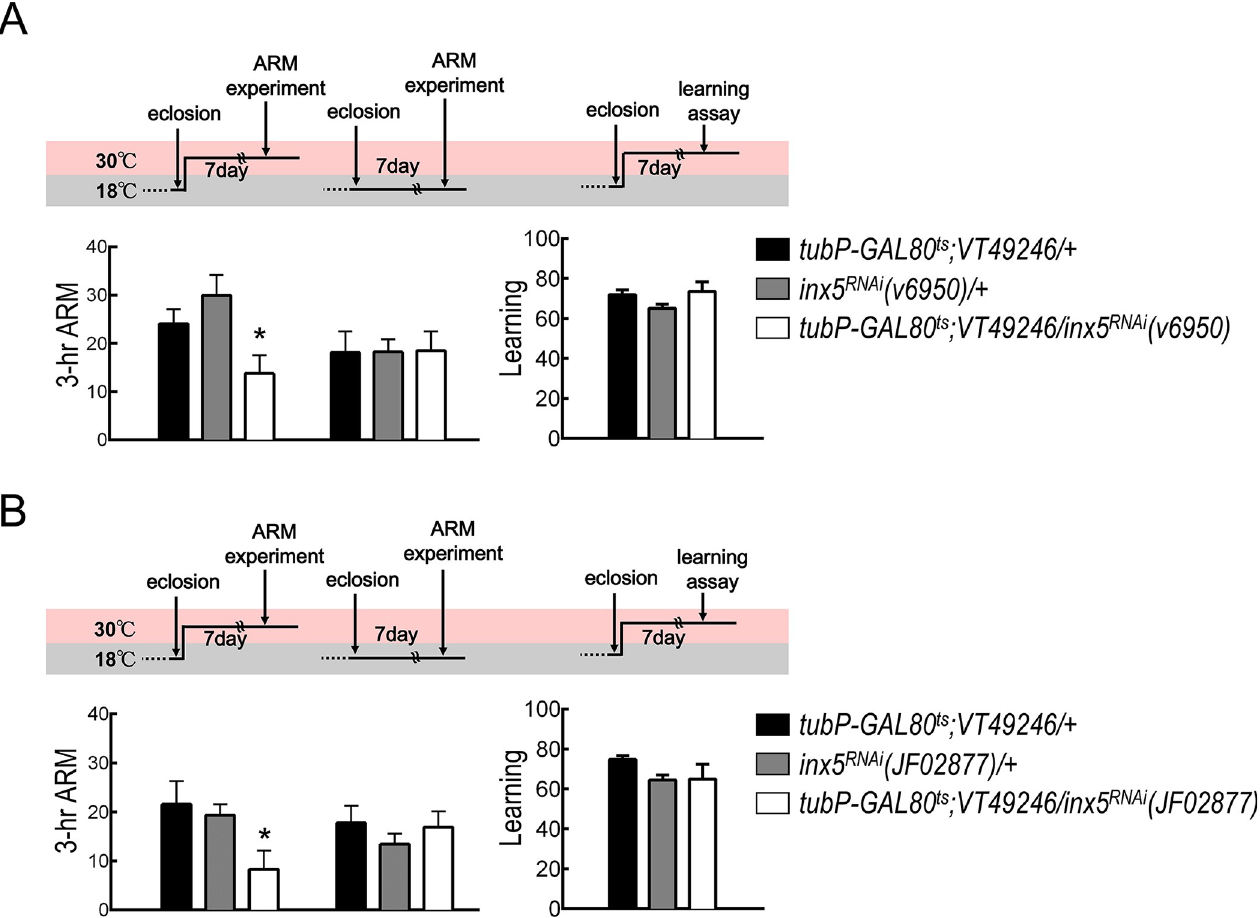
Fig 4. Inducible knockdown of inx5 in αβ neurons disrupts ARM. (A) Adult-stage-specific INX5 knockdown disrupted ARM but not initial learning. Each value represents the mean ± S.E.M. (n = 8–13). � , p < 0.05; ANOVA followed by Tukey’s test. The genotypes were as follows: (1) tubP-GAL80 ts /+; VT49246-GAL4/+ , (2) +/+; UAS-inx5 RNAi (v6950)/+ , and (3) tubP-GAL80 ts /+; VT49246-GAL4/UAS-inx5 RNAi (v6950) . (B) Additional RNAi effector was used to confirm the role of INX5 in 3-hour ARM formation. Each value represents the mean ± S.E.M. (n = 8–10). � , p < 0.05; ANOVA followed by Tukey’s test. The genotypes were as follows: (1) tubP-GAL80 ts /+; VT49246-GAL4/+ , (2) +/+; +/UAS-inx5 RNAi (JF02877) , and (3) tubP-GAL80 ts /+; VT49246-GAL4/UAS- inx5 RNAi (JF02877)